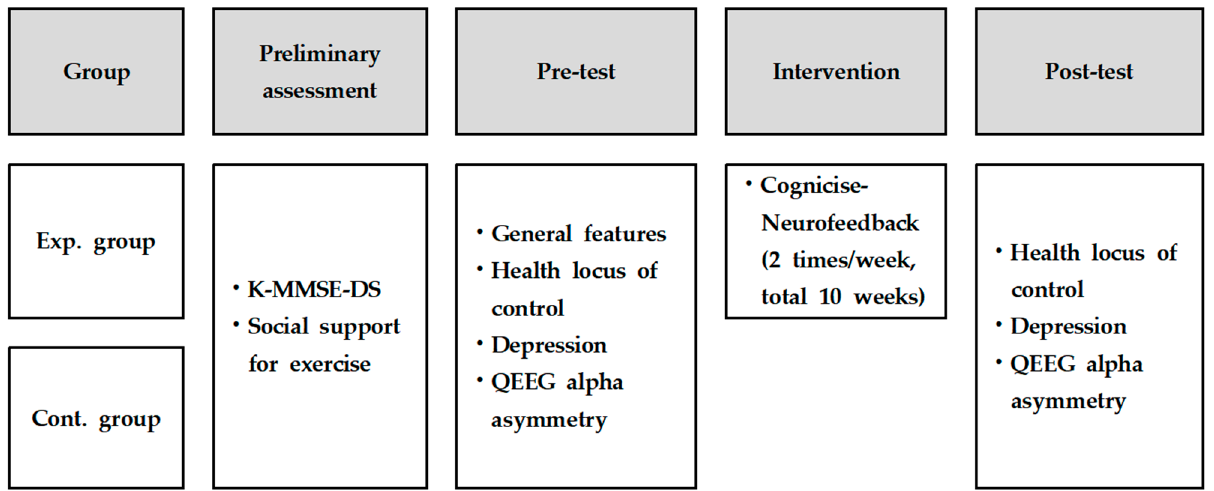
Figure 1. Research design. Exp., experimental; Cont., control; K-MMSE-DS, Korean version of the Mini-Mental State Examination for Dementia Screening; QEEG, Quantitative electroencephalography.